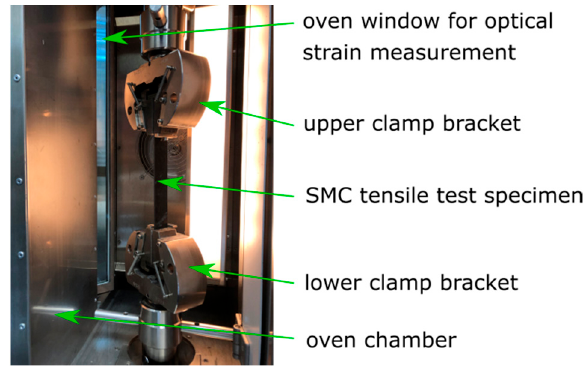
Figure 6. Tensile creep test in an oven chamber of a universal testing machine.